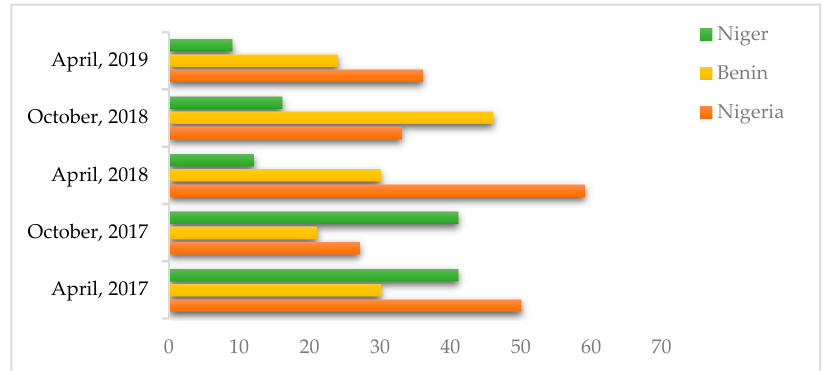
Figure 3. Number of respondents to CC challenges in the selected countries.